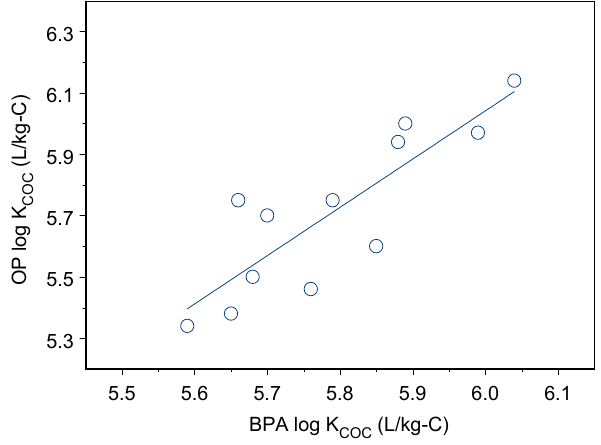
Figure 3. Linear regression between OP and BPA log K COC .